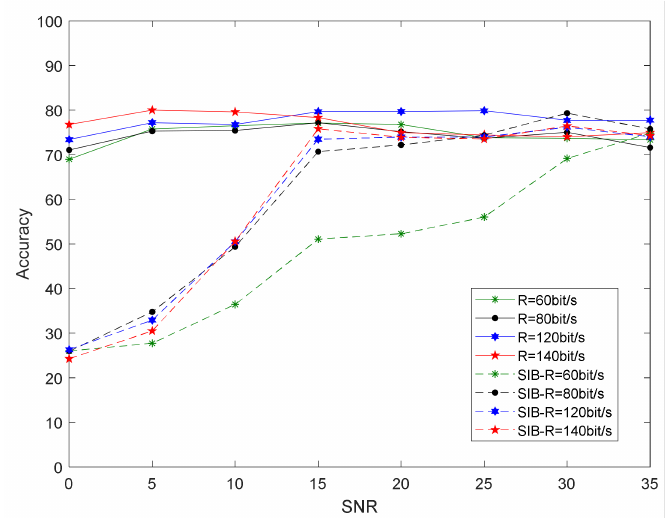
Figure 14. Classification-accuracy results of the proposed method and bispectral method under different SNR conditions after changing test-set information